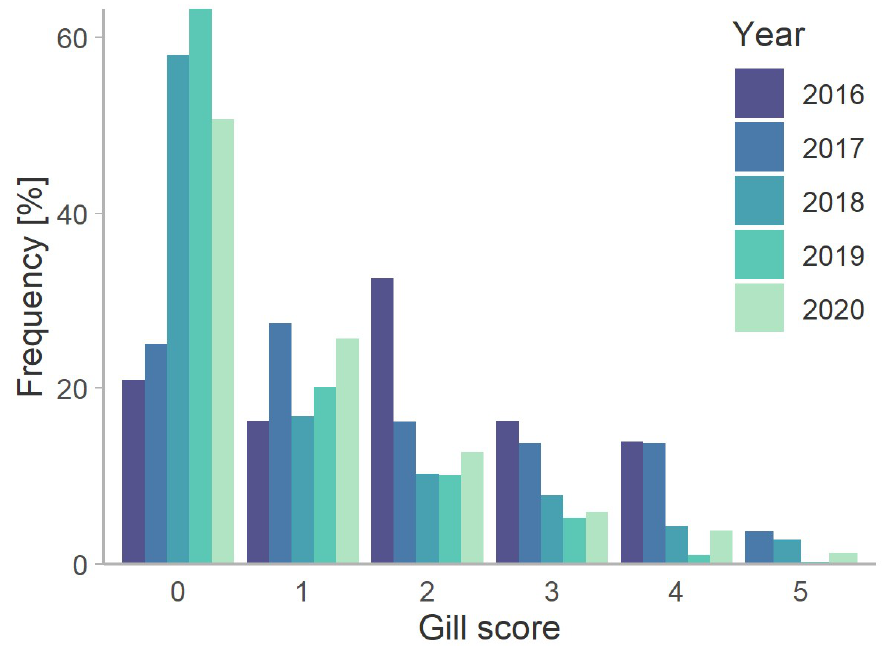
Figure 2. Atlantic salmon visual gill scores among all health management zones by year (n = 1898). Fisheries and Oceans Canada’s Fish Health Audit and Surveillance (DFO-FHAIP) data collected in British Columbia. Table 2. The effect of Atlantic salmon gill scores (low, <2; high, ≥ 2) on the number (percent) of samples with histopathological lesions between 2016 and 2020.